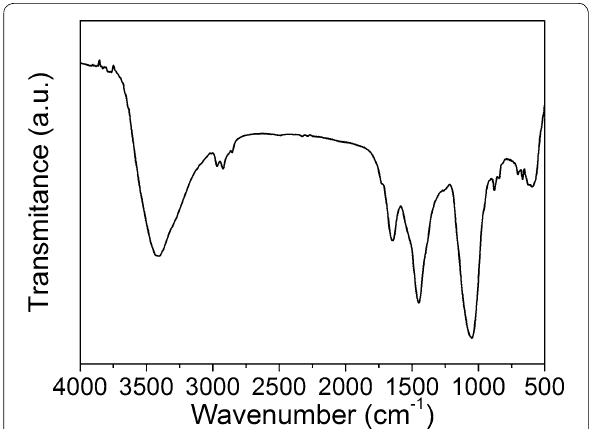
Fig. 3 Characteristic FTIR spectrum for EPS from A.